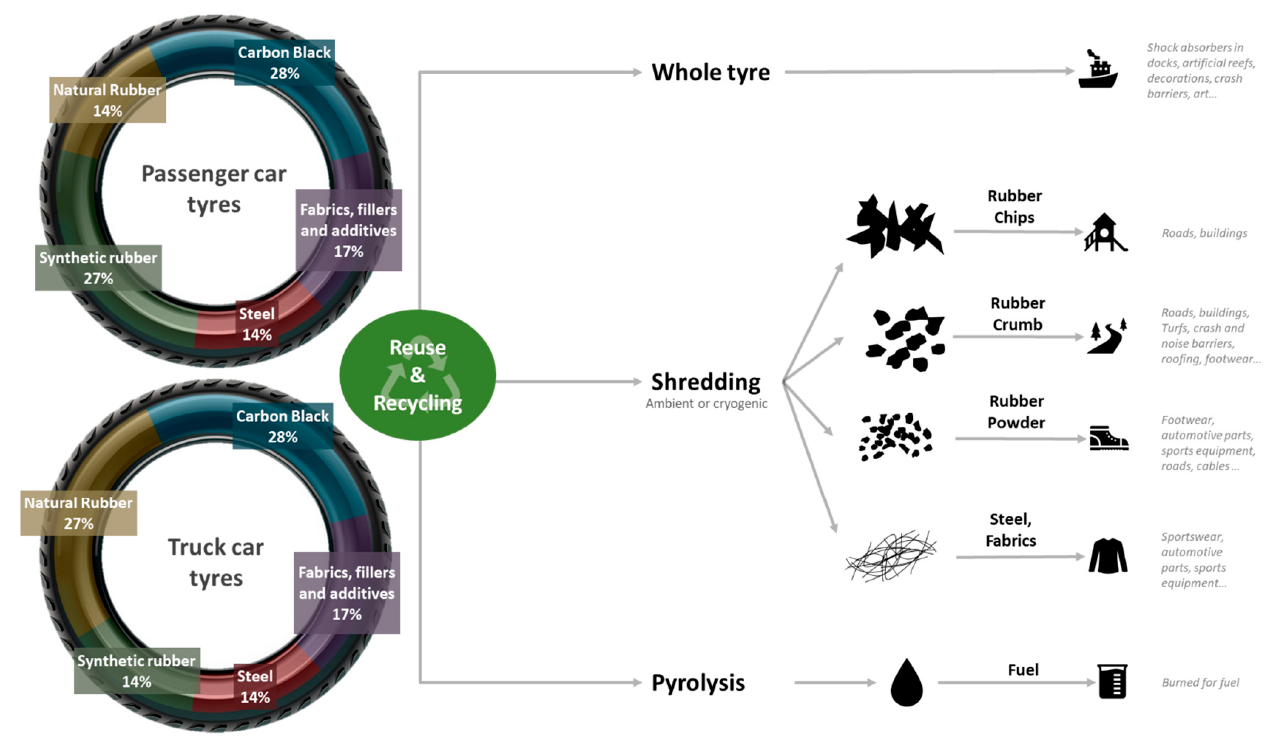
Figure 1. Different rubber recycling processes and potential applications (adapted from European Tyre Recycling Association, Rubber Manufactures’ association, Swedish Tyre Recycling Association).